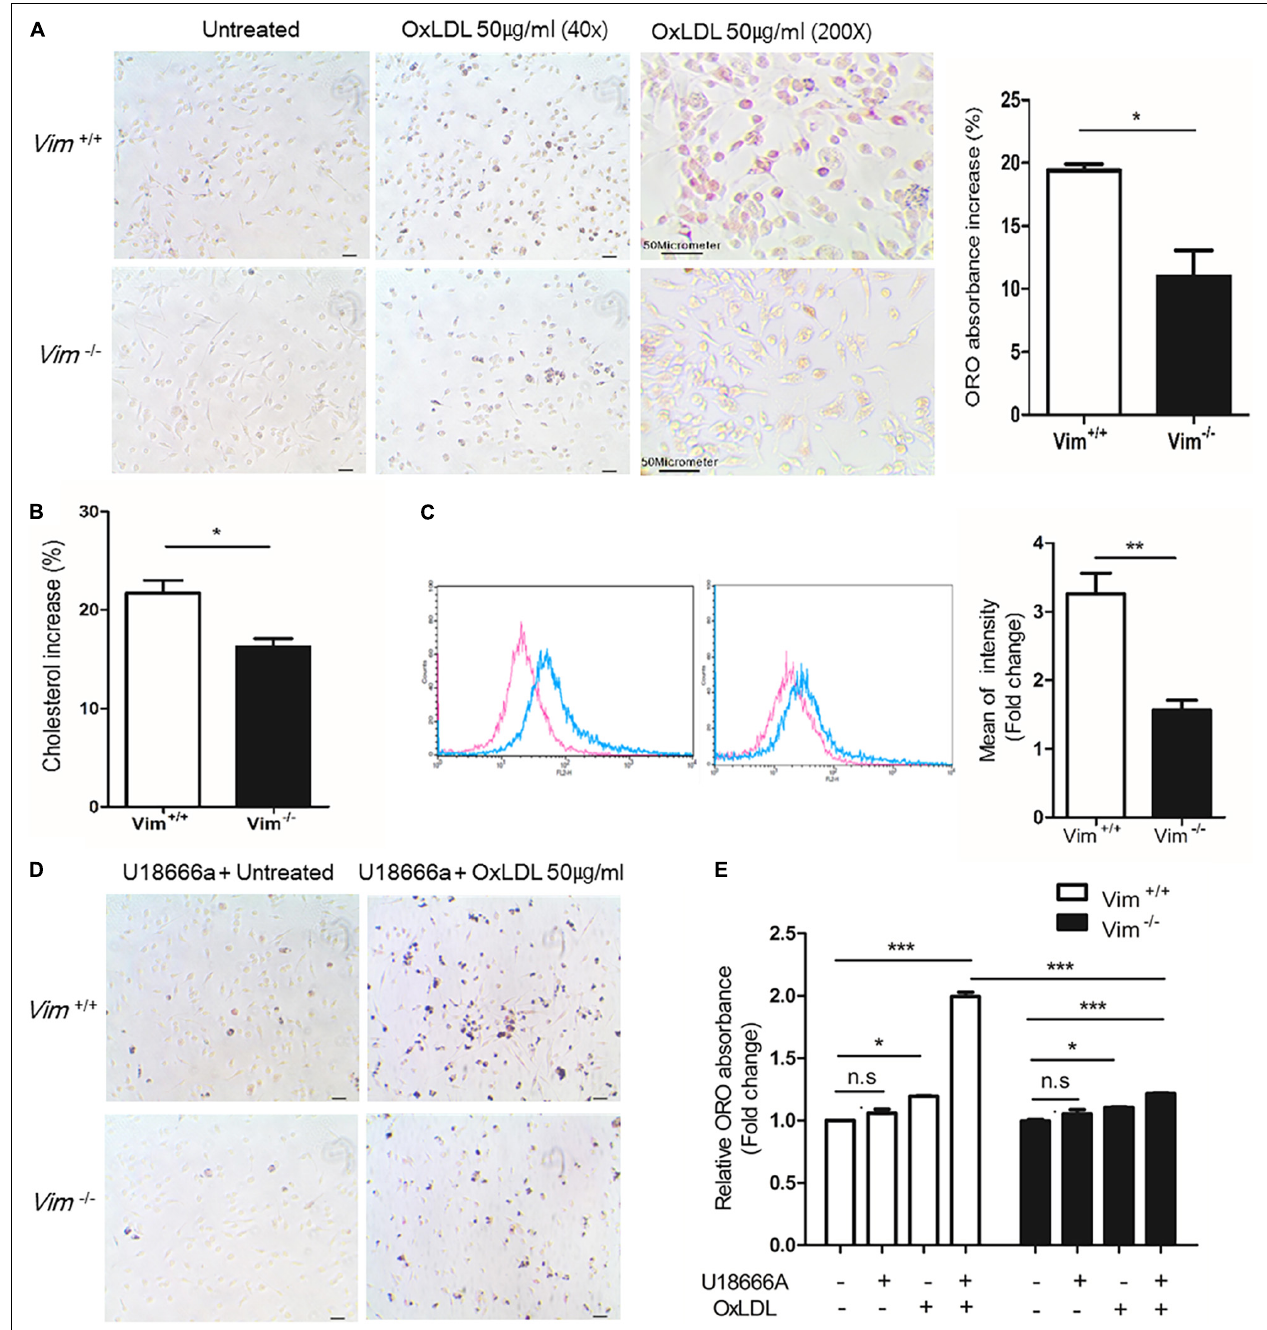
FIGURE 1 | Vim − / − murine peritoneal macrophages exhibit less foam cell formation and less uptake of oxLDL than Vim + / + macrophages. (A) Left, Representative images of ORO staining of Vim + / + mouse macrophages and Vim − / − mouse macrophages. Both macrophages were incubated with or without oxLDL (50 µ g/ml) for 18 h. Right: the absorbance of ORO eluted from macrophages in (A) . The absorbance increases induced by oxLDL treatment were compared between Vim + / + and Vim − / − macrophages. (B) Increases of Intracellular cholesterol concentration in Vim + / + mouse macrophages and Vim − / − mouse macrophages were compared after incubation with oxLDL 50 µ g/ml for 18 h. (C) Left, Flow cytometry. Vim + / + mouse macrophages and Vim − / − mouse macrophages were pretreated with non-labeled oxLDL for 30 min, and then exposed to oxLDL complexed with DiI (DiI-oxLDL, 50 µ g/ml) for 5 min and fixed with 4% paraformaldehyde. The fluorescence intensities of these cells were measured using flow cytometry. Red line; without oxLDL, Blue line; with oxLDL. Right graph: Geometric mean fluorescence intensities were compared between Vim + / + and Vim − / − macrophages incubated with oxLDL. The bar graph of comparison was generated from 3 times of separate experiments. (D) Representative images of ORO staining of Vim + / + and Vim − / − mouse macrophages. Both macrophages were pre-incubated with U18666a (NPC inhibitor, 10 nM) for 90 min and then incubated with or without oxLDL (50 µ g/ml) for 18 h. (E) Relative ratio of absorbance of eluted ORO in (A,D) . The ORO was extracted using isopropanol and the absorbance representing intracellular lipids was detected at 540 nm. (* p < 0.05, ** p < 0.01, *** p < 0.001. The graph shows mean ± SEM for triplicated determinants of 3 separate